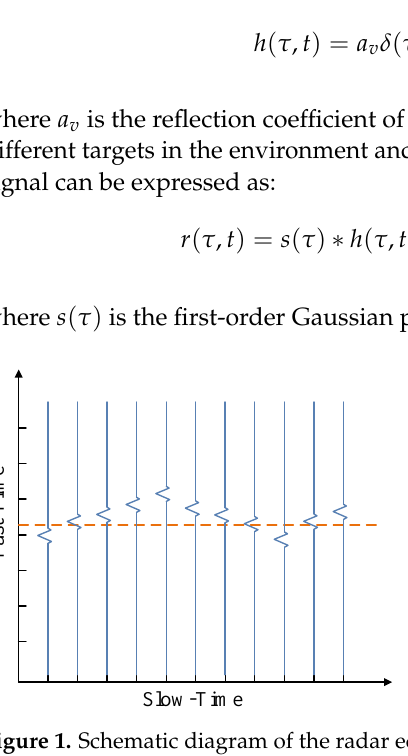
Figure 1. Schematic diagram of the radar echo signal.